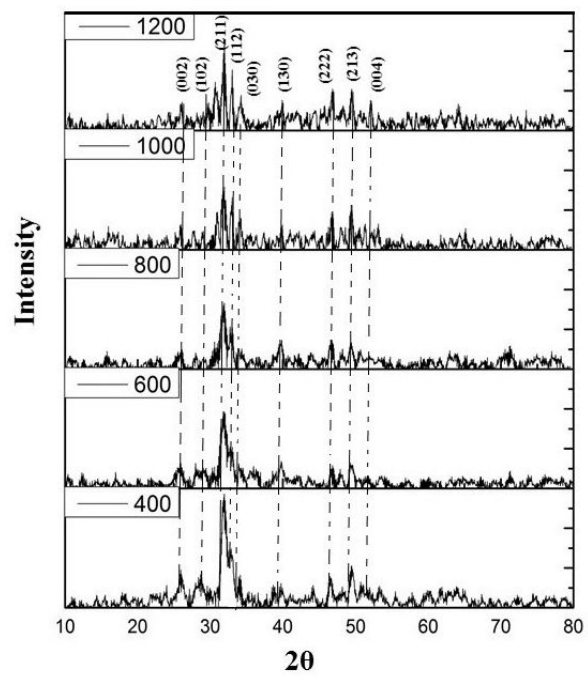
Figure S6: XRD spectra of the hydroxyapatite with increasing sintering